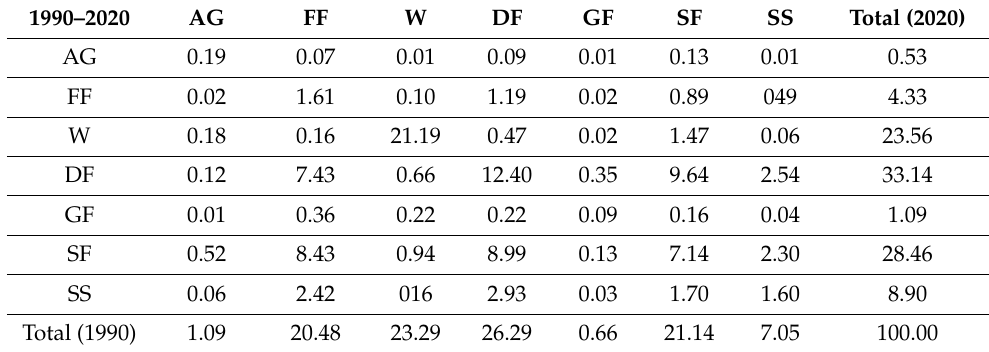
Table 2. Transition matrix of land cover units (%) between 1990 and 2020.